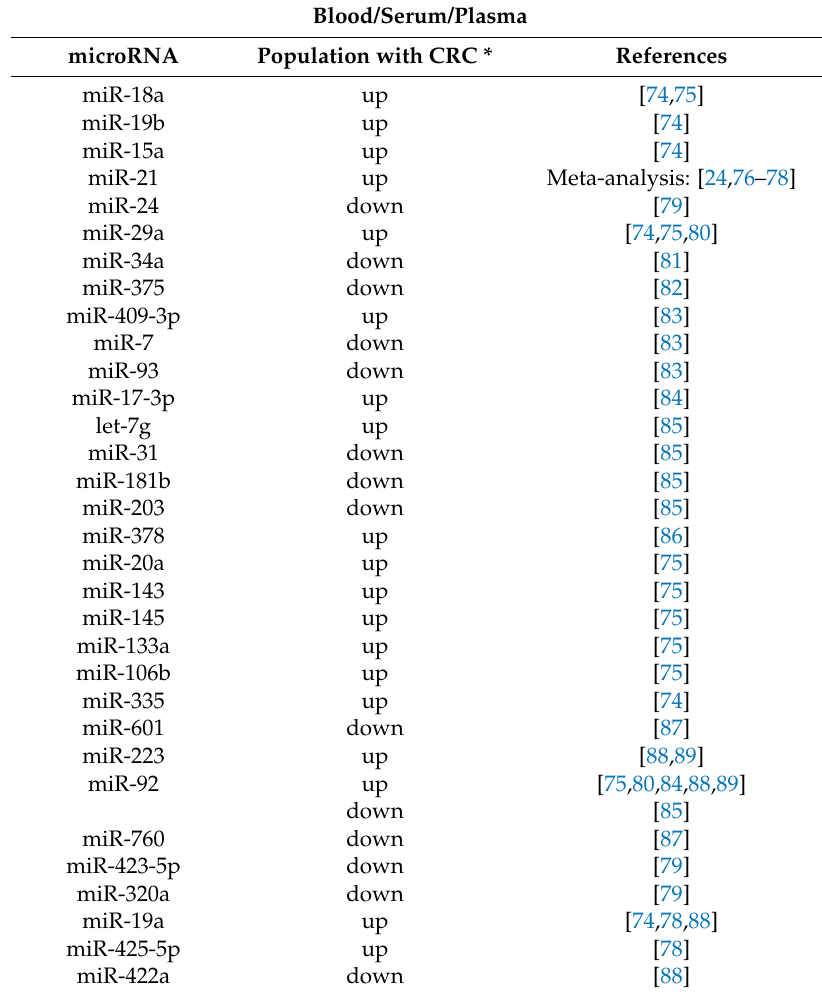
Table 2. Blood and stool microRNAs as diagnostic biomarkers for